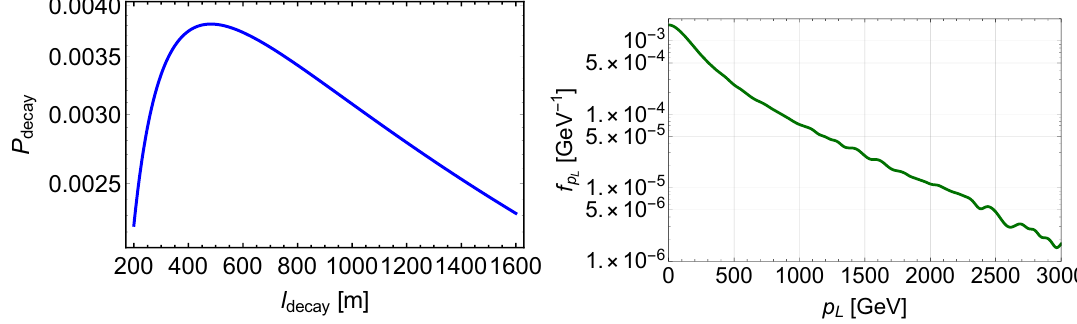
Figure 3 . Left panel : A probability of the scalar decay for FASER 2 as a function of a scalar’s decay length l decay . Right panel : the distribution function f p momentum p L . The simulations are based on MadGraph5 aMCNLO [71] and following [72]. See appendix A for